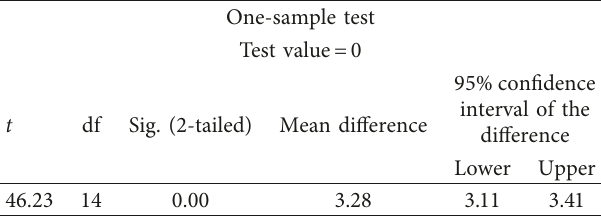
Table 10: One-sample test of the students’